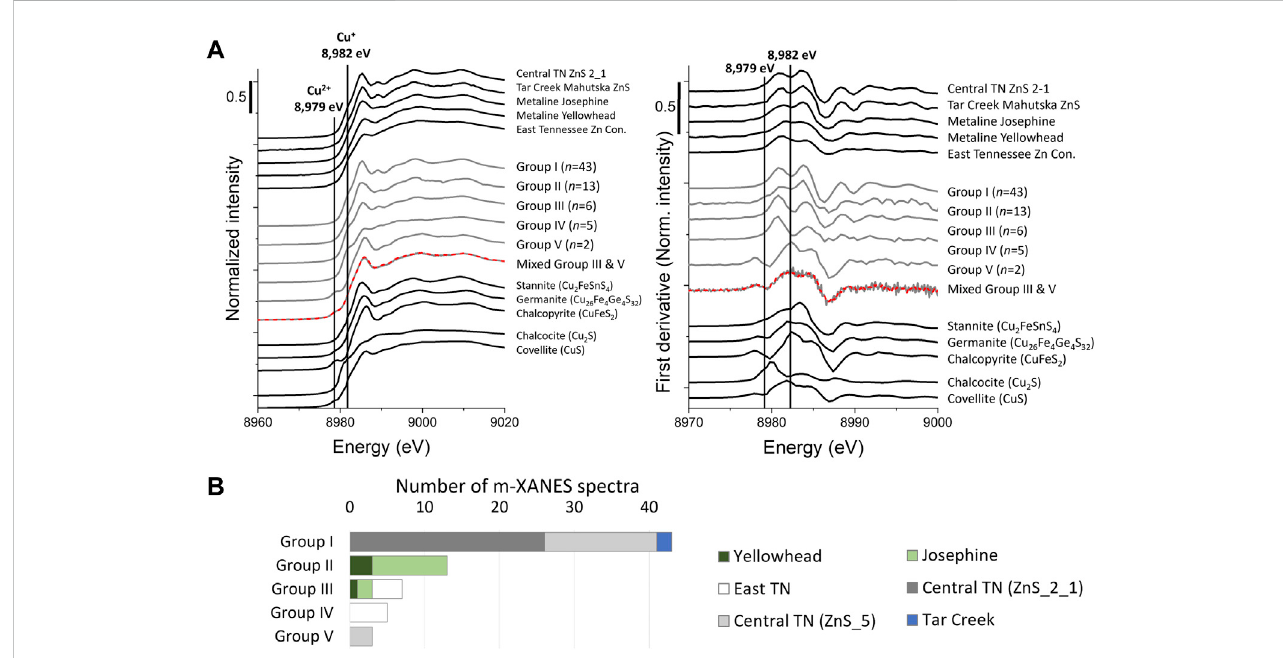
FIGURE 10 CopperXANES (A) Normalizedreferencespectraand fi rstderivativeofnormalizedspectraofbulksamples(topblackspectra),grouped μ -XANES(middle grayspectra), andreference minerals(bottomblackspectra). Notethebottommicro-focusedspectra withlinear combination fi t(reddashedline),which was found to contain a mixture of 72% group V and 28% group III , indicating the Cu bonding environment occasionally varied within the 2 – 3 μ m of the incident X-ray beam. (B) Bar chart showing how μ -XANES spectra from each sample were grouped. These μ -XANES spectra were averaged to create μ -XANES groups shown in Figure